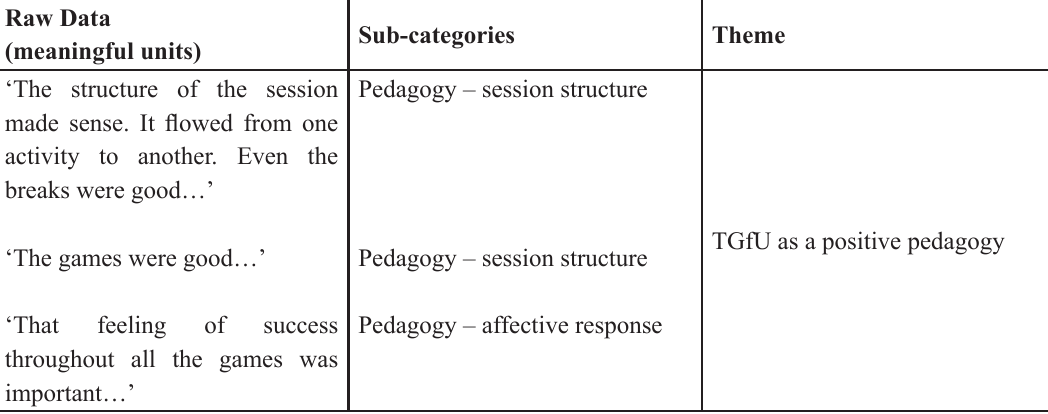
Table 2: Data classification example - meaningful units, sub-categories and